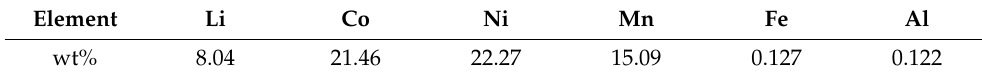
Table 1. Main metal contents in cathode material of spent lithium batteries.